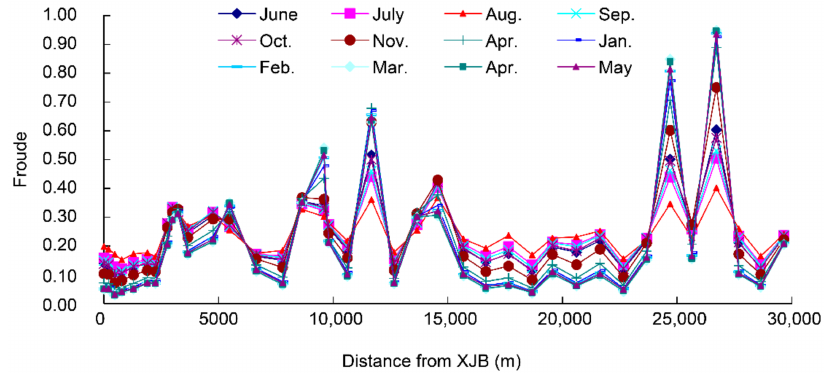
Figure 9. Wetted perimeter rate for each month during typical dry years in the study area.